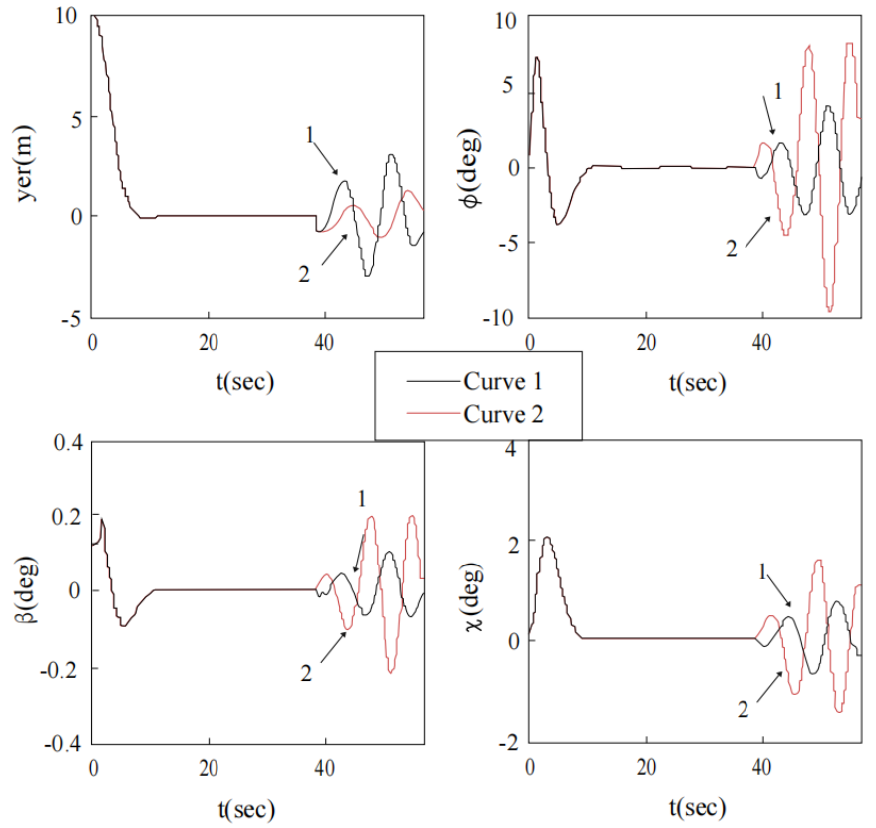
Figure 32. The curve of compensation effects for deck motion with yaw compensation command ACLS Lat